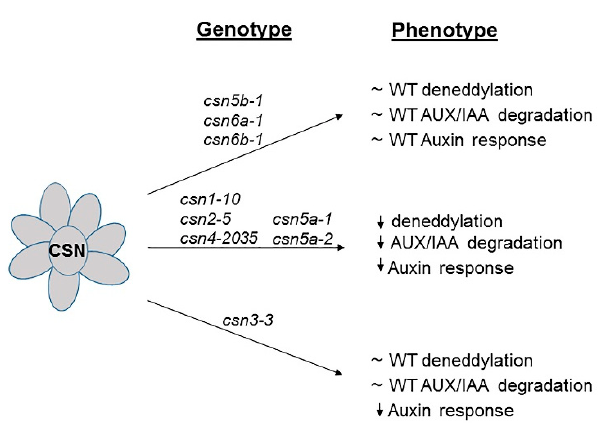
Figure 1. Schematic representation of the influence of hypomorphic mutants of the CSN on deneddylation, AUX/IAA degradation and auxin response.